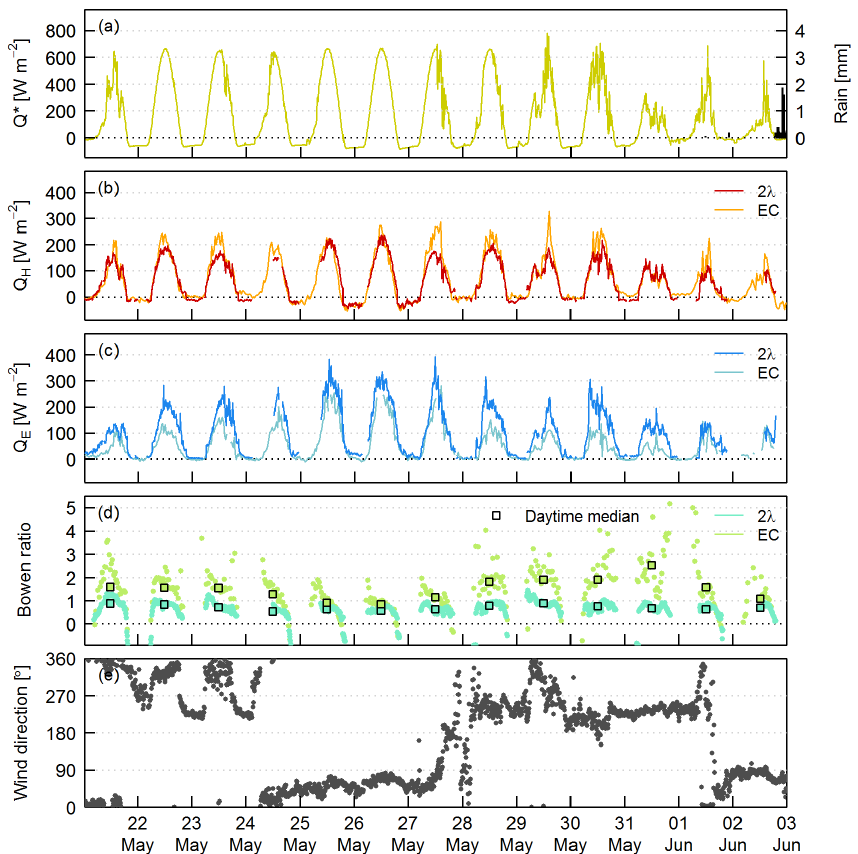
Figure 6. Energy partitioning according to eddy covariance and scintillometry during a warm, dry period in spring 2012. In (d) only daytime data are shown.